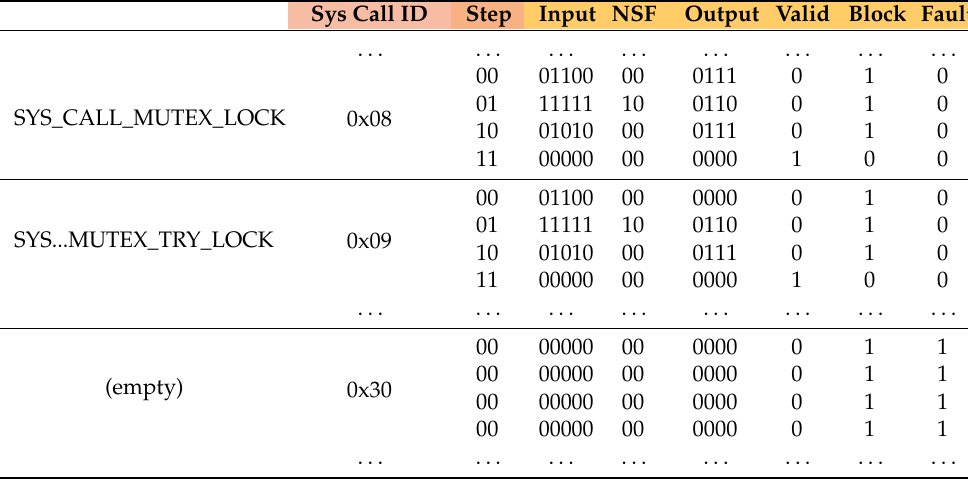
Table 1. Binary excerpt from the Microprogram composed by the bit field values in the opcode, combined with the corresponding Program Counter absolute address